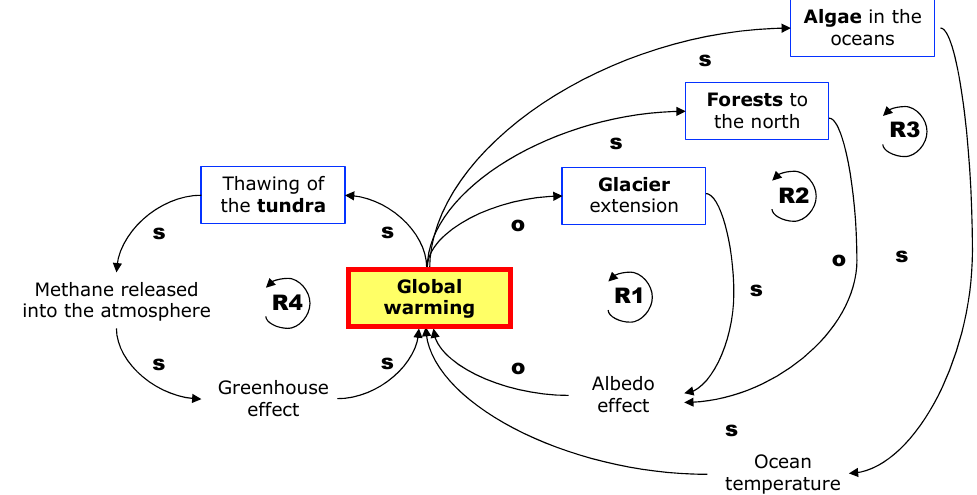
Figure 7. Action of four harmful reinforcing loops that increase global warming.